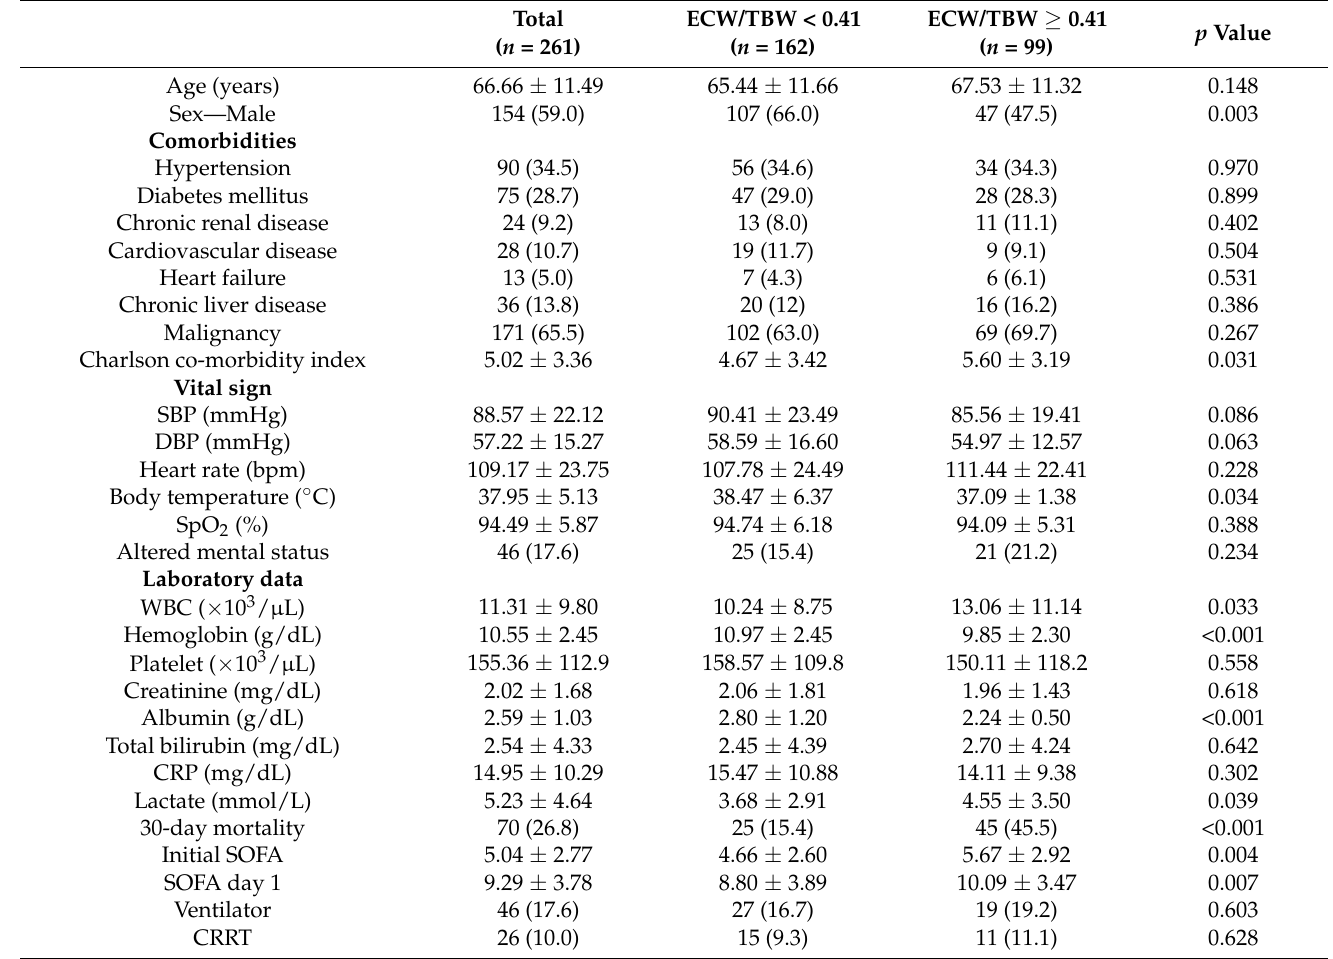
Table 3. Comparison of the clinical characteristics based on the